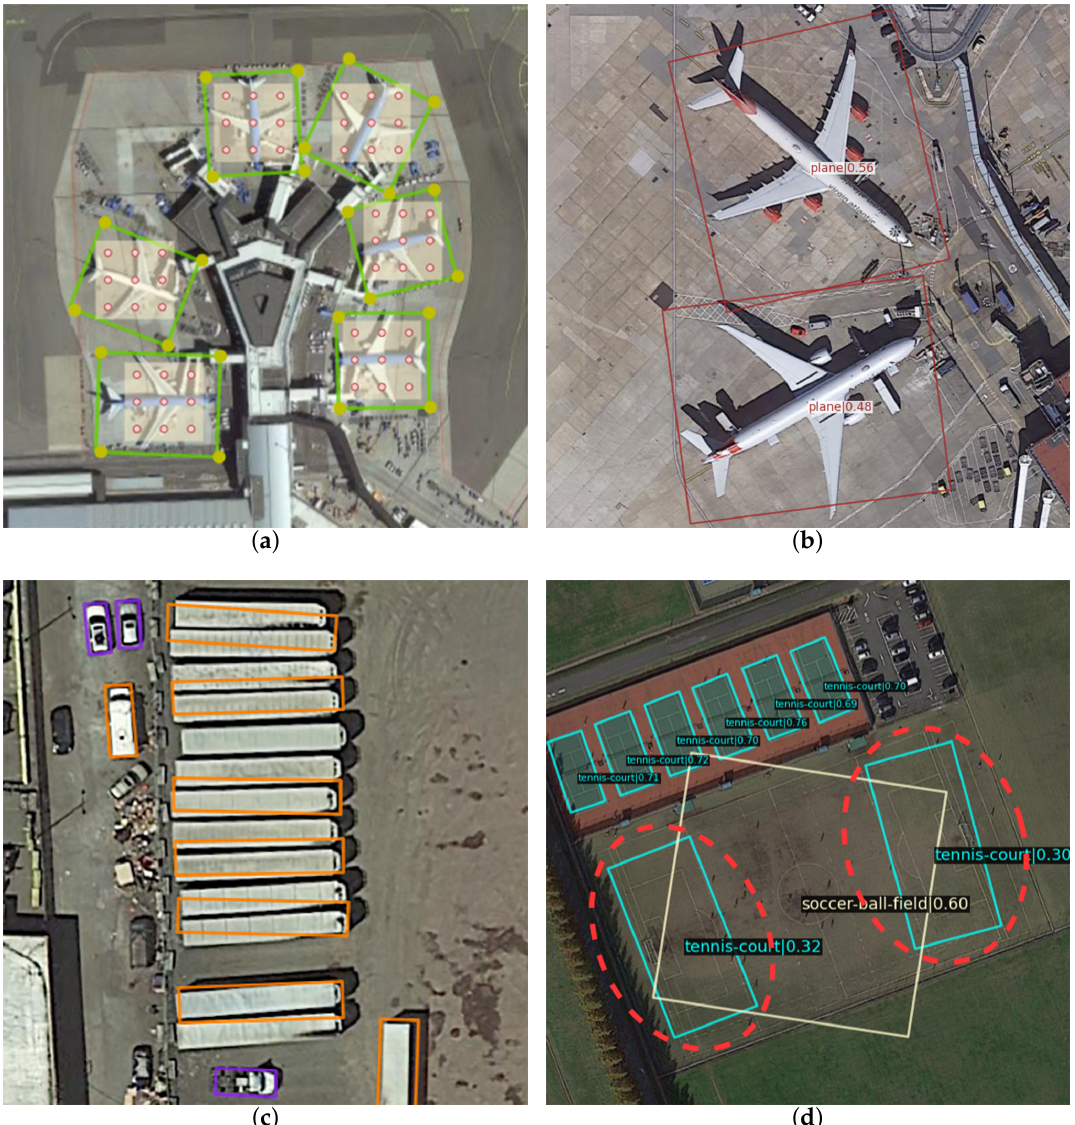
Figure 1. ( a ) The sampling axis of the regular convolution does not match the remote-sensing target with different orientations. The green box is the ground truth, the yellow points are the four vertices, and the red points are the sampling points of the convolution. ( b ) Axial misalignment leads to regression error in predicting rotated boxes. ( c ) Missed detection of densely arranged remote-sensing targets due to spatial misalignment. ( d ) Classification errors caused by semantic misalignment(red dashed circle). A portion of the soccer field was misdetected as a tennis